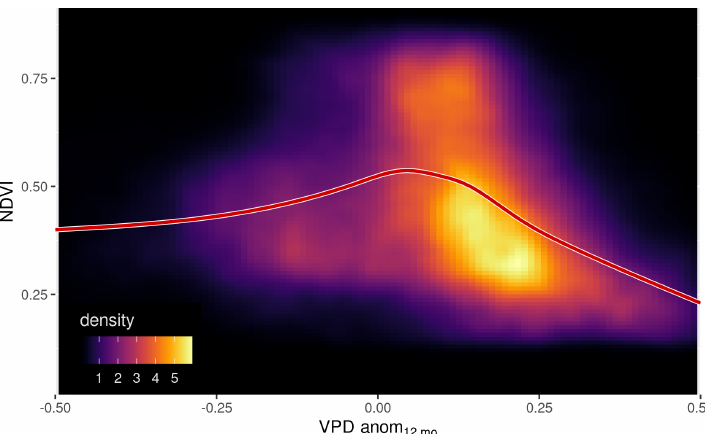
Figure A11. The nonlinear dependency of NDVI upon the annual anomaly of vapor pressure deficit. Two-dimensional density plot of NDVI and the running 12-month anomaly of vapor pressure deficit. The red line shows a GAM fit.